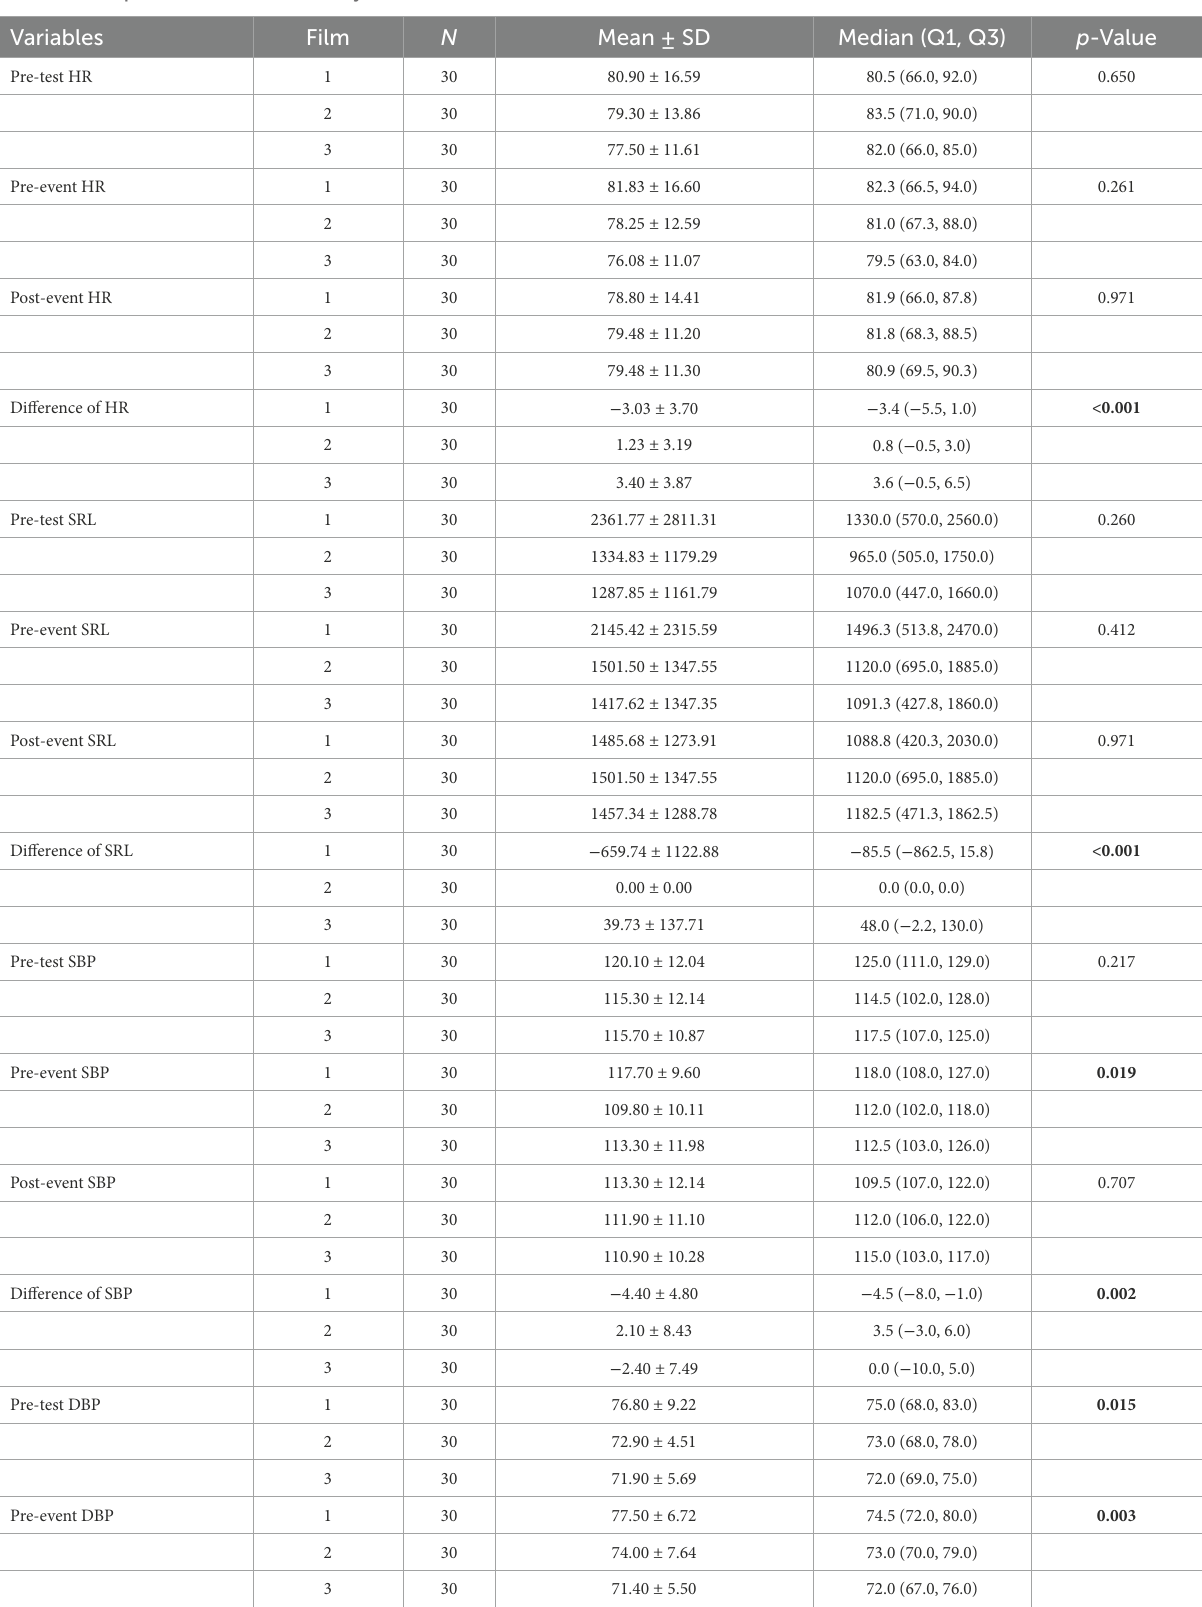
TABLE 2 Descriptive statistics of variables by